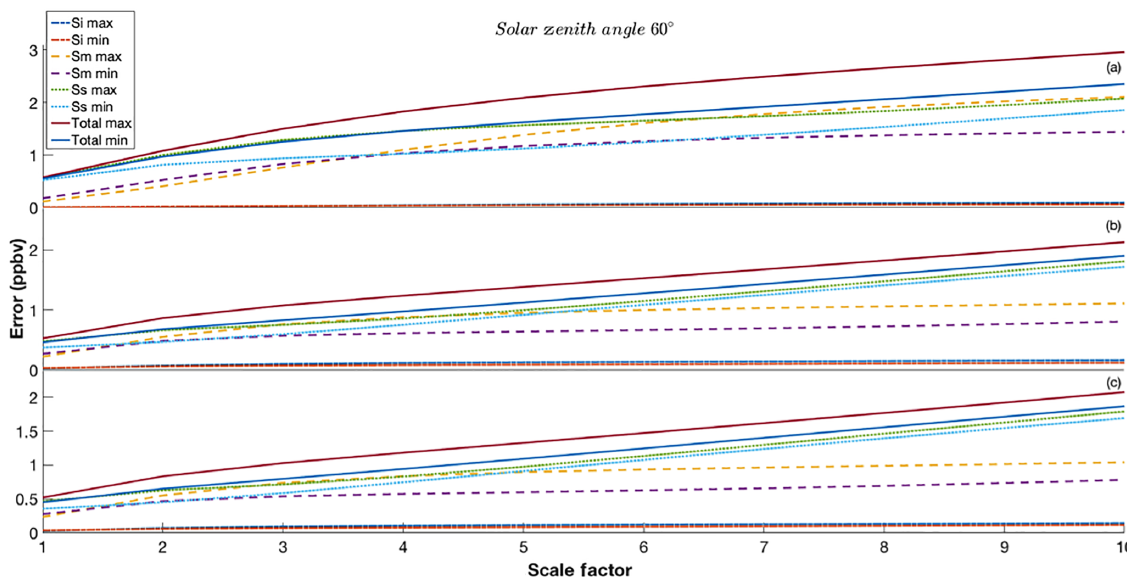
Figure A3. Synthetic total column retrieval errors retrieval for scenarios outlined in Table 3, based on Eqs. (8), (9), (10) and (16). The maximum and minimum values (based on maximum and minimum SNR) for interference, measurement and smoothing error are shown, in addition to the total error: panel (a) indicates scenario 2, panel (b) indicates scenario 5 and panel (c) indicates scenario 8.